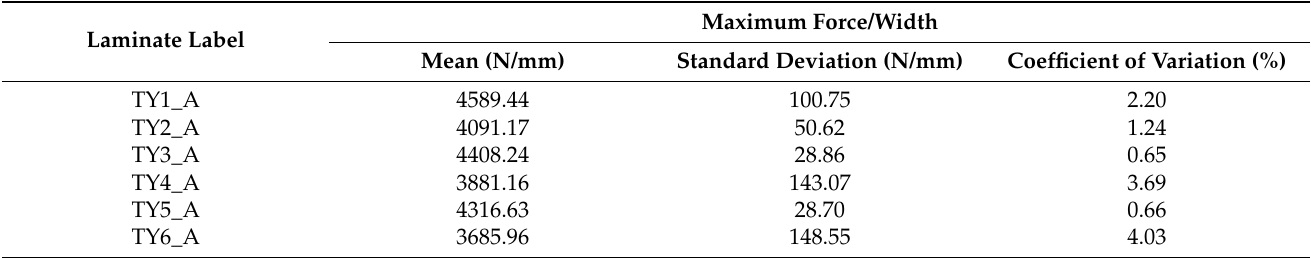
Table 2. Maximum tensile force per unit width for different batches of specimens.